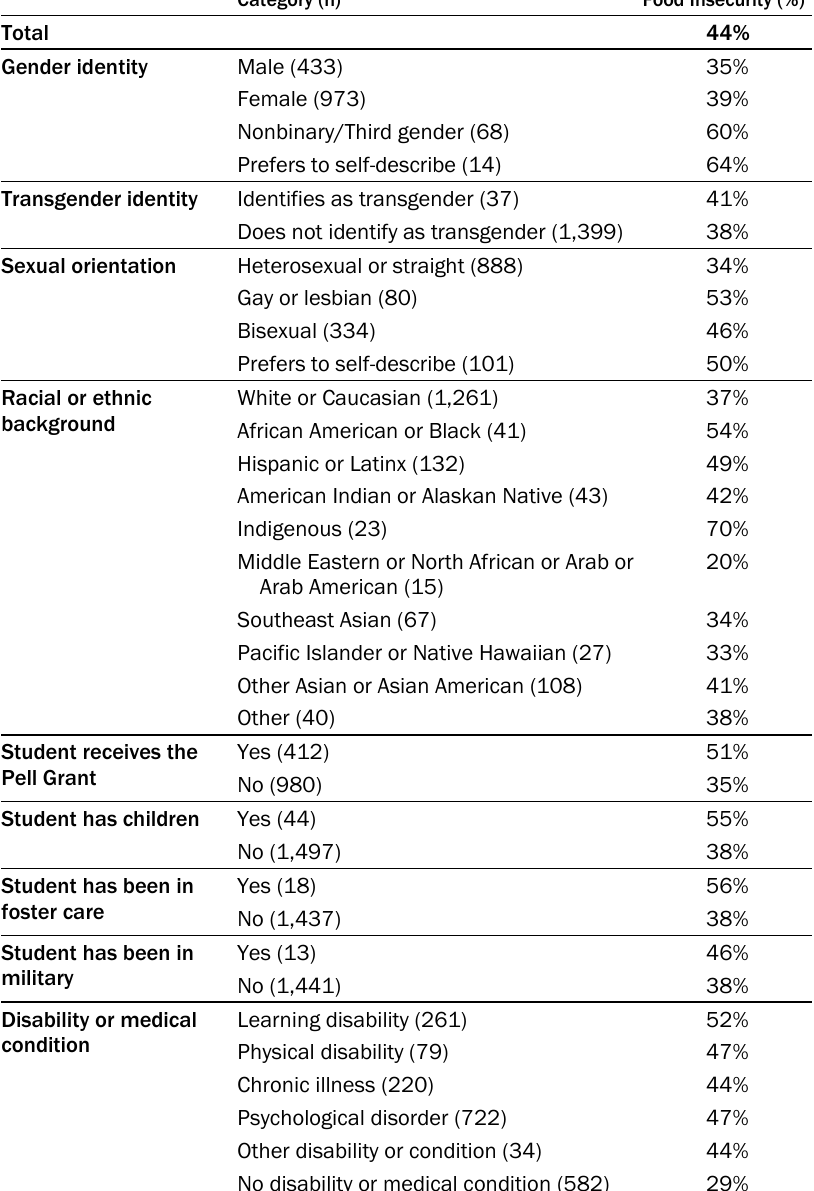
Table 1. Food Insecurity Rates at WWU by Category,